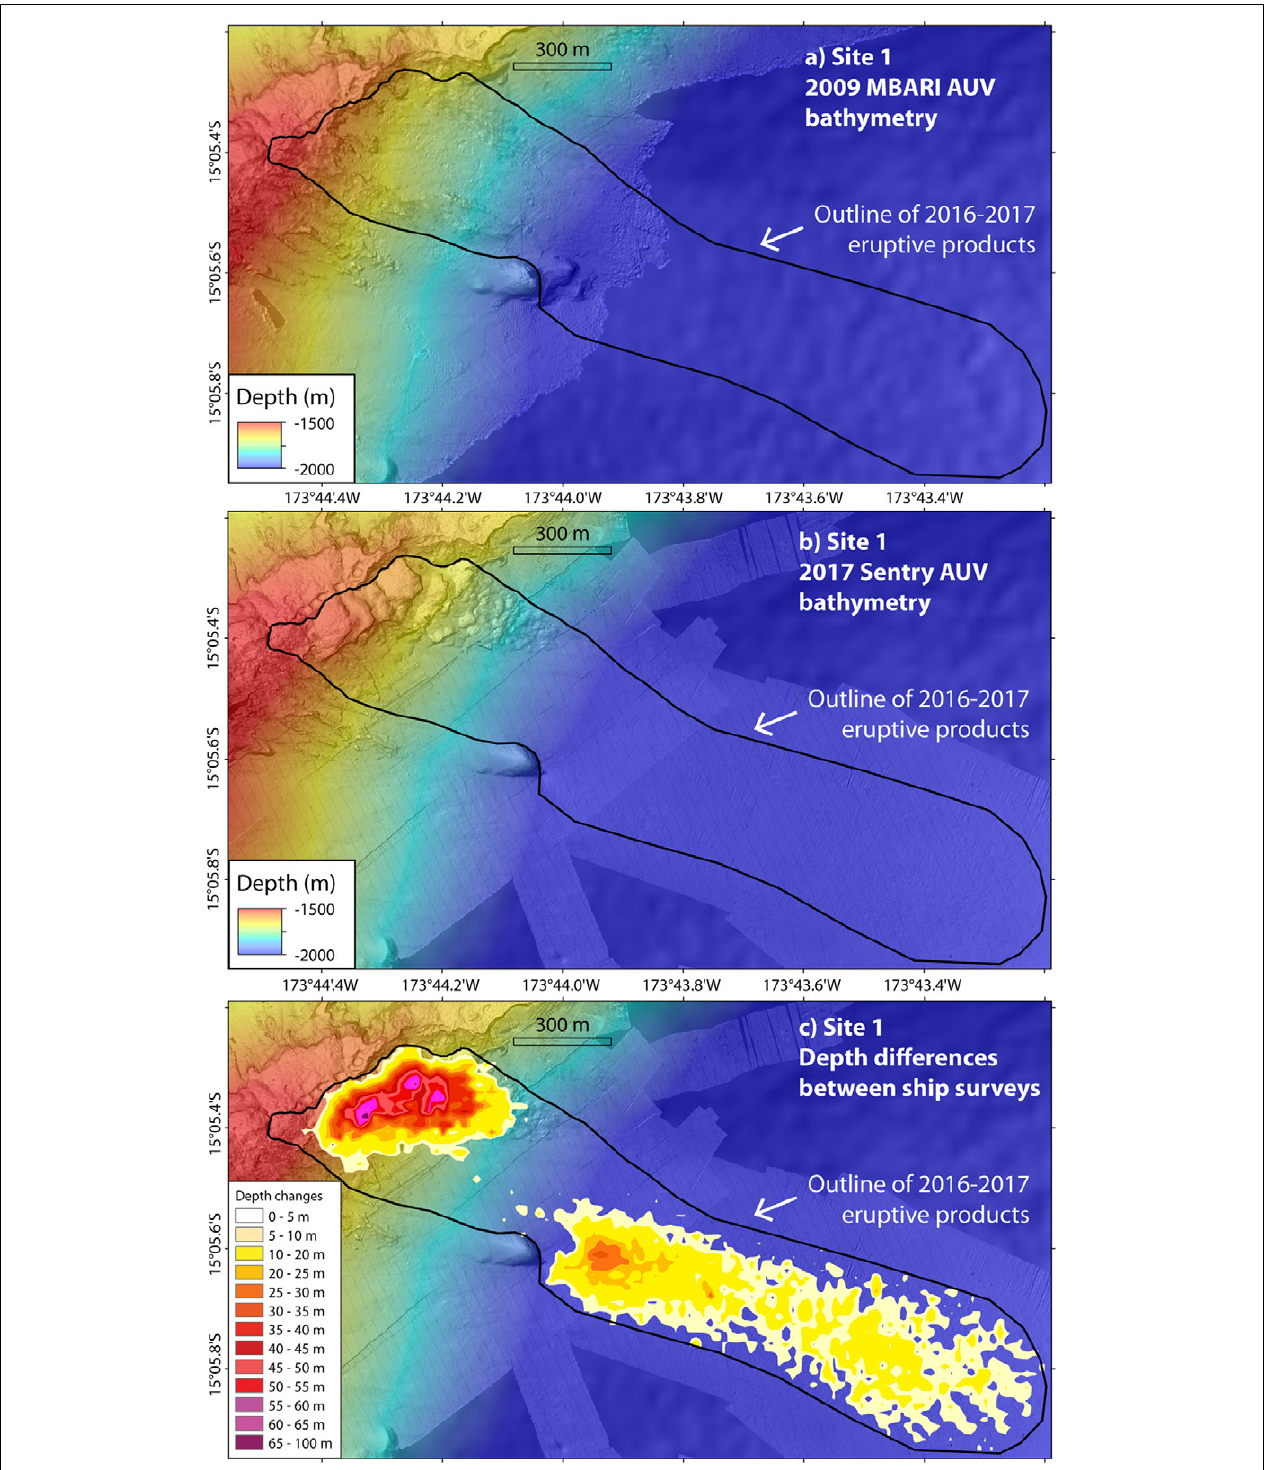
FIGURE 4 | Broad-view maps of eruption site #1, on the middle ENE rift zone of West Mata (see Figure 2 ) showing (a) pre-eruption MBARI AUV bathymetry from 2009, (b) post-eruption Sentry AUV bathymetry from 2017, and (c) positive depth differences between ship-based surveys in 2016 and 2017 overlain on 2017 AUV bathymetry (see Table 2 ). Black outlines enclose the site #1 eruption deposits. In this and subsequent figures, the pre-eruption AUV bathymetry was collected in May 2009 by the MBARI AUV D. Allan B. (Clague et al., 2011; Clague, 2015), and the post-eruption AUV bathymetry is from surveys in November 2017 with AUV Sentry (Merle et al.,